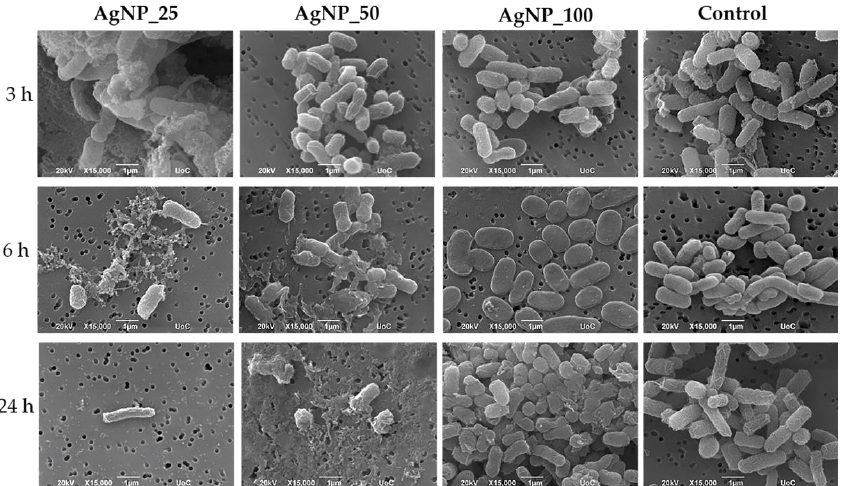
Figure 2. Representative SEM images showing the induction of 100 ppm AgNPs on E. coli for 3, 6, and 24 h. The control represents the morphology of the bacteria without AgNPs. Magnification is 15,000x and scale bar represents 1 μm.